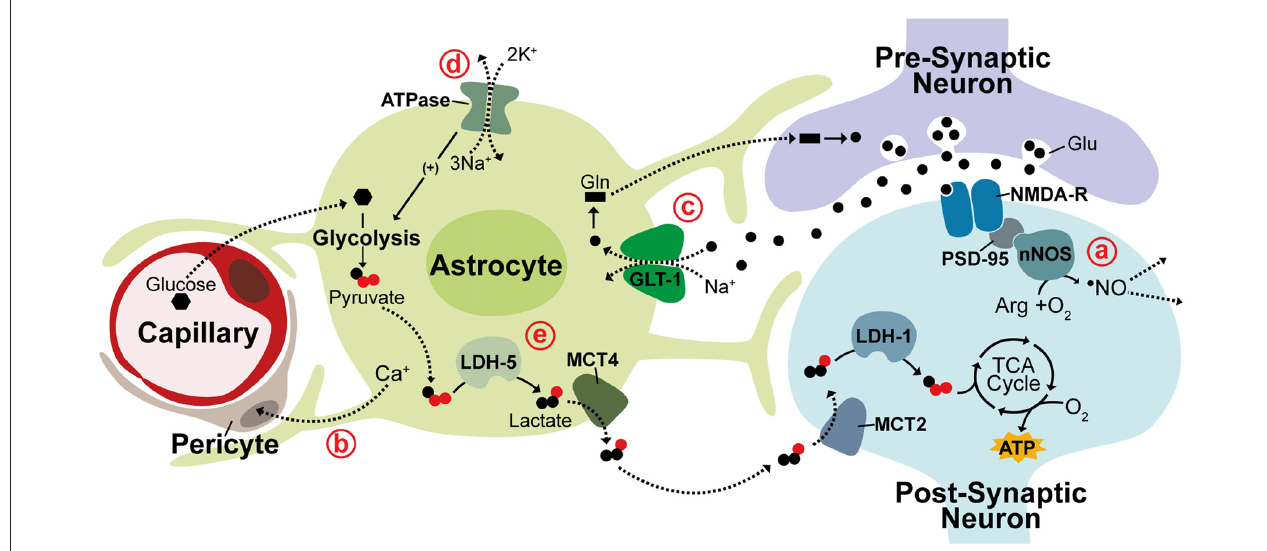
FIGURE 1 | Neurovascular and neurometabolic coupling mechanisms. Schematic illustrating neuronal and astrocytic mechanisms responsible for activity-related blood flow and metabolic changes. (a) NMDA receptors (NMDA-R) are linked to neuronal nitric oxide synthase (nNOS) through post-synaptic density protein 95 (PSD-95) and neurovascular coupling during activity is thought to be triggered through the neuronally-produced vasodilator • NO, which can diffuse rapidly and freely through membranes to act on arterioles. (b) Vasodilation is also thought to be controlled at the capillary level through astrocytic Ca + signaling acting on contractile perictyes. (c) In the glutamine-glutamate cycle, glutamate (Glu) released into the synaptic cleft is cleared by Na + -dependent astrocytic uptake, primarily through GLT-1. Glutamate is converted to glutamine (Gln) and returned to neurons to replenish neurotransmitter stores. (d,e) The astrocyte-neuron lactate shuttle (ANLS) hypothesis suggests associated increases in astrocytic Na + concentration triggers activation of Na + /K + ATPase pumps, promoting glucose uptake and glycolysis. Glycolytically-generated lactate is released and utilized as a substrate for oxidative phosphorylation in neurons during periods of activity. LDH, lactate dehydrogenase; MCT, monocarboxylate transporter. Solid lines indicate enzymatic activity, dashed lines indicate solute